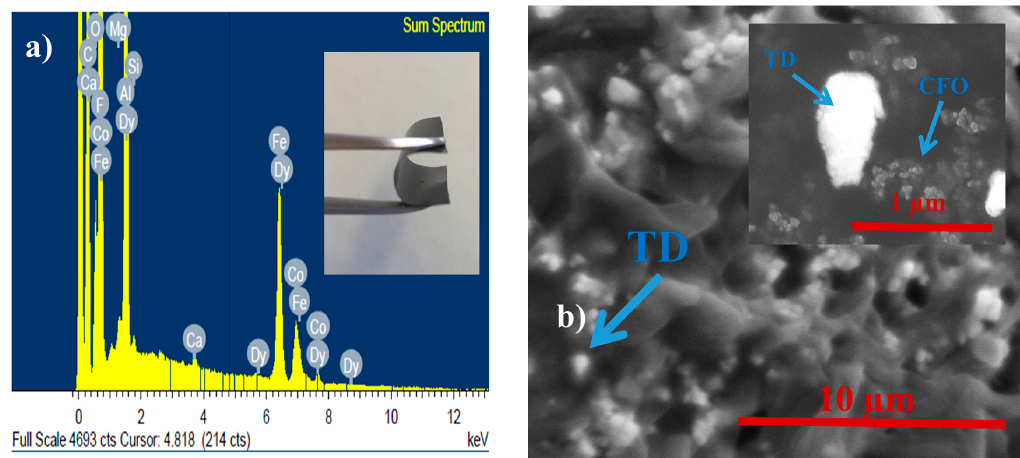
Figure 1. ( a ) EDS analysis of the 20TD/20CFO composite (inset reveals a photograph of such a flexible composite); and ( b ) SEM image showing the TD dispersion on the 20TD/20CFO composite as a magnification showing both magnetostrictive particles (inset).